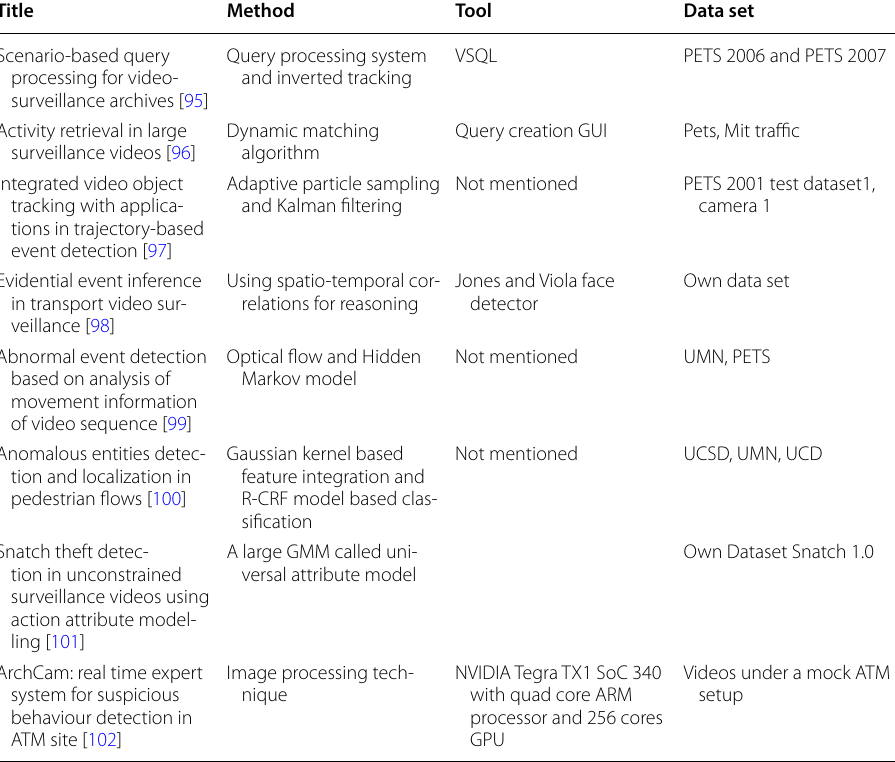
Table 8 Summary of different techniques in video analysis Title Method Tool Data